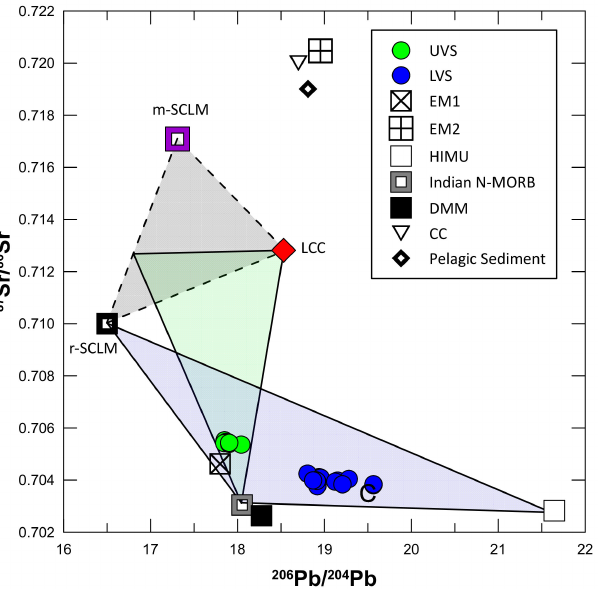
Figure 19. A proposed three component mixing model for the Christmas Island lava series